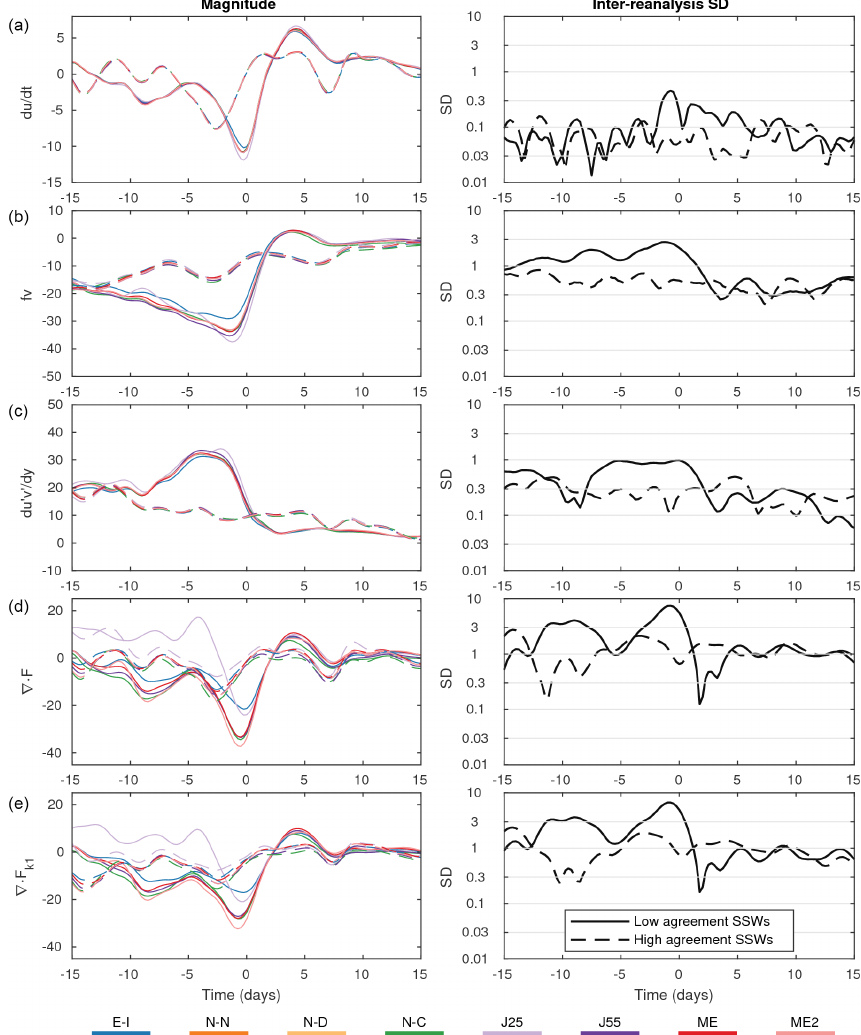
Figure 11. Similar to Fig. 5 but for comparing SSW events with small (HASSWs – dashed lines) and large uncertainties (LASSWs – solid lines). EP flux divergence is shown for all wavenumbers (d) as well as wavenumber 1 (e) . All diagnostics are shown at 10 hPa and are in units of ms − 1 day − 1